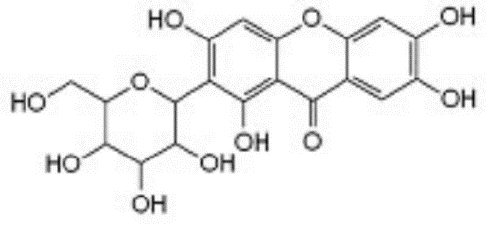
Figure 1. Chemical structure of mangiferin (C 19 H 18 O 11 Figure 1. Chemi cal structure of mangiferin (C₁₉H₁₈O₁₁).